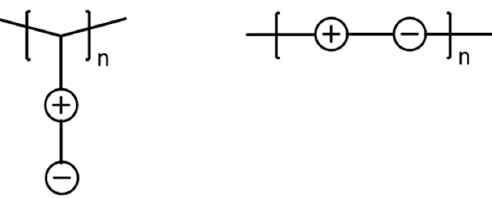
Figure 1. Examples of possible distributions of ionic groups within zwitterionic polymers (schematic representation).